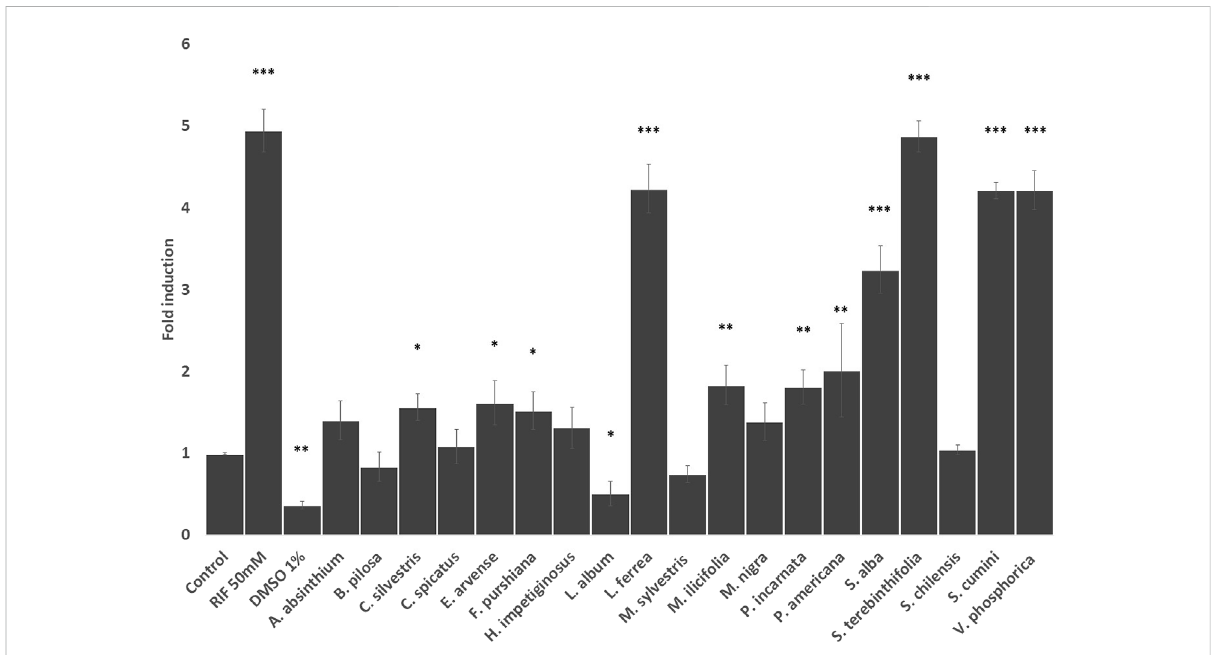
FIGURE 4 Effects of the selected herbal preparations (100 μ g/ml) and Rifampicin (RIF, 50 mM, positive reference) on the expression of CYP 3A4 in HEPG2 cells (Mean ± SEM, n ≥ 3). Statistical signi fi cance against DMSO 0.2% (control) according to Bonferroni (* p < 0.05, ** p < 0.01, *** p <